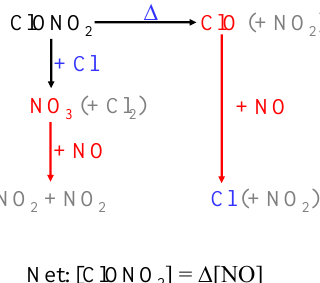
Scheme 1. The ClONO 2 detection scheme used in our